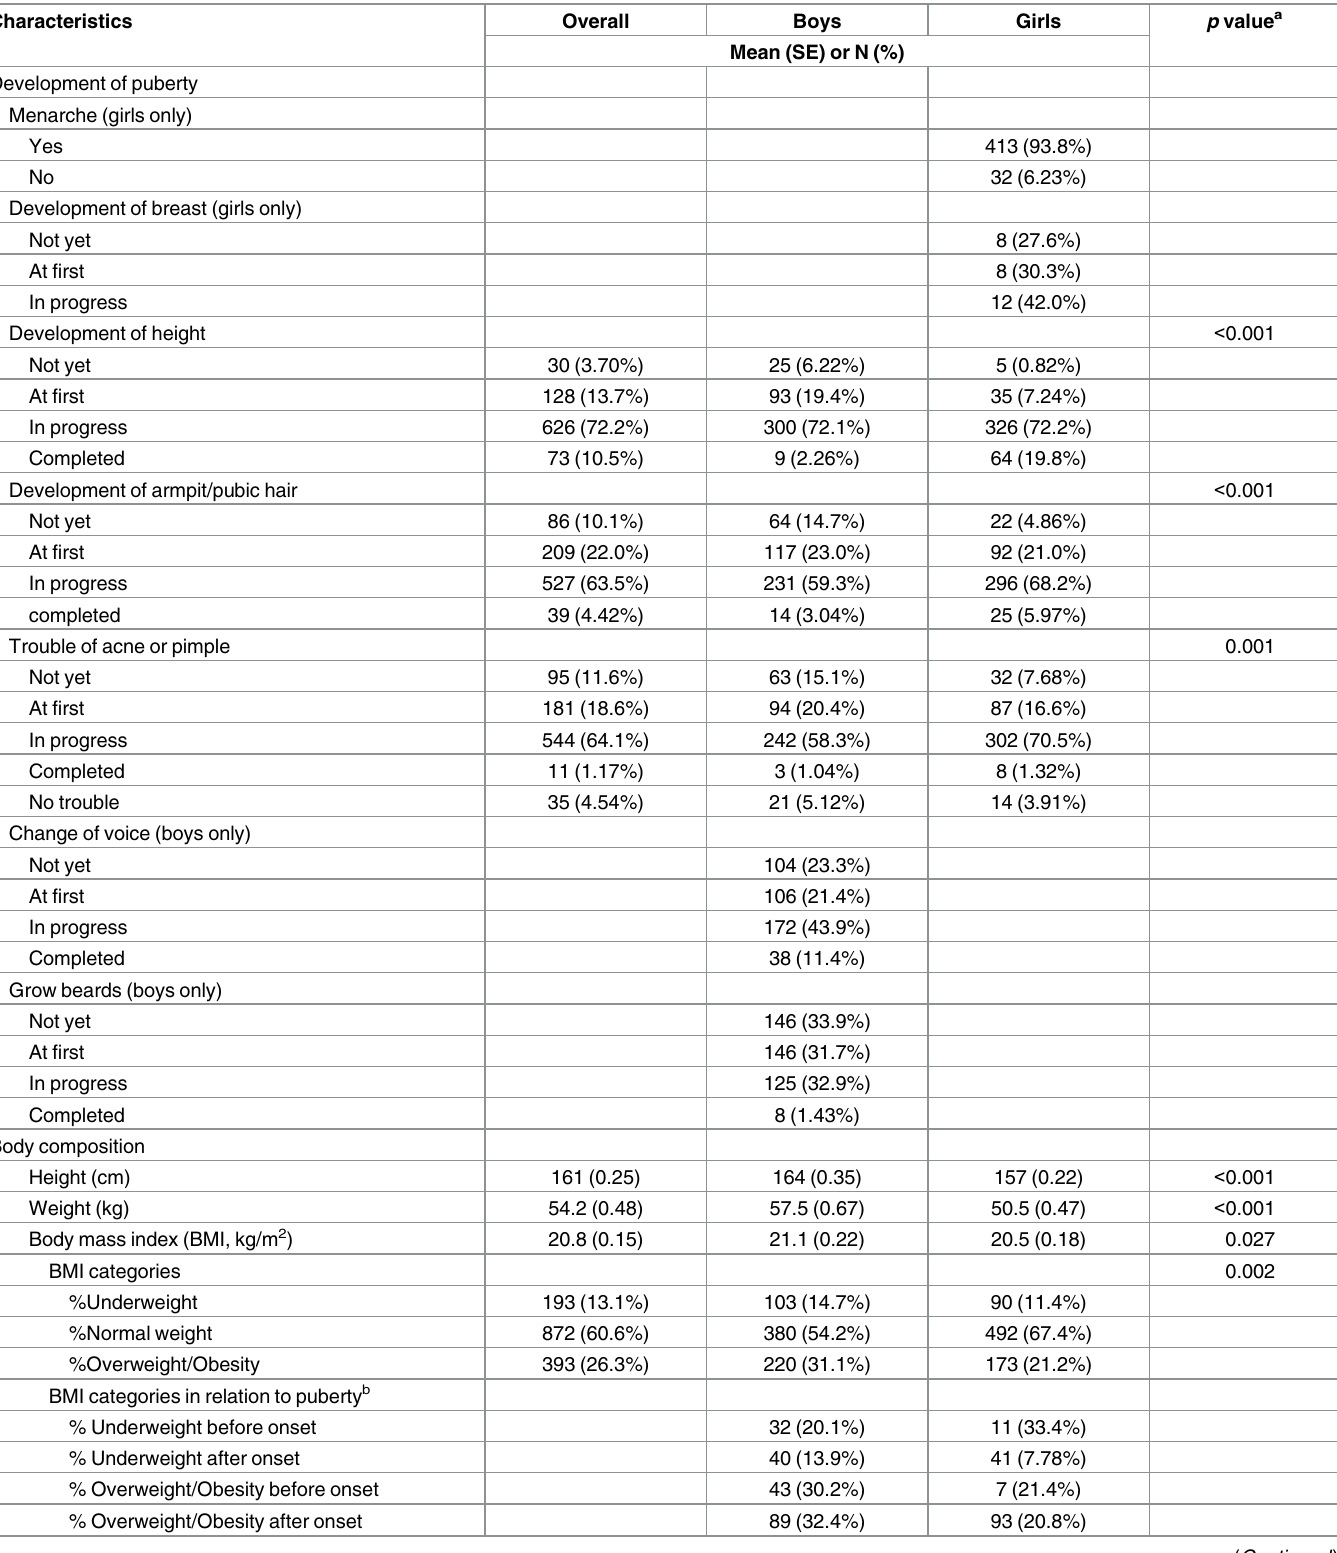
Table 2. Puberty and anthropometric characteristics of junior high school students by gender (N = 1458, 11–16 years old).